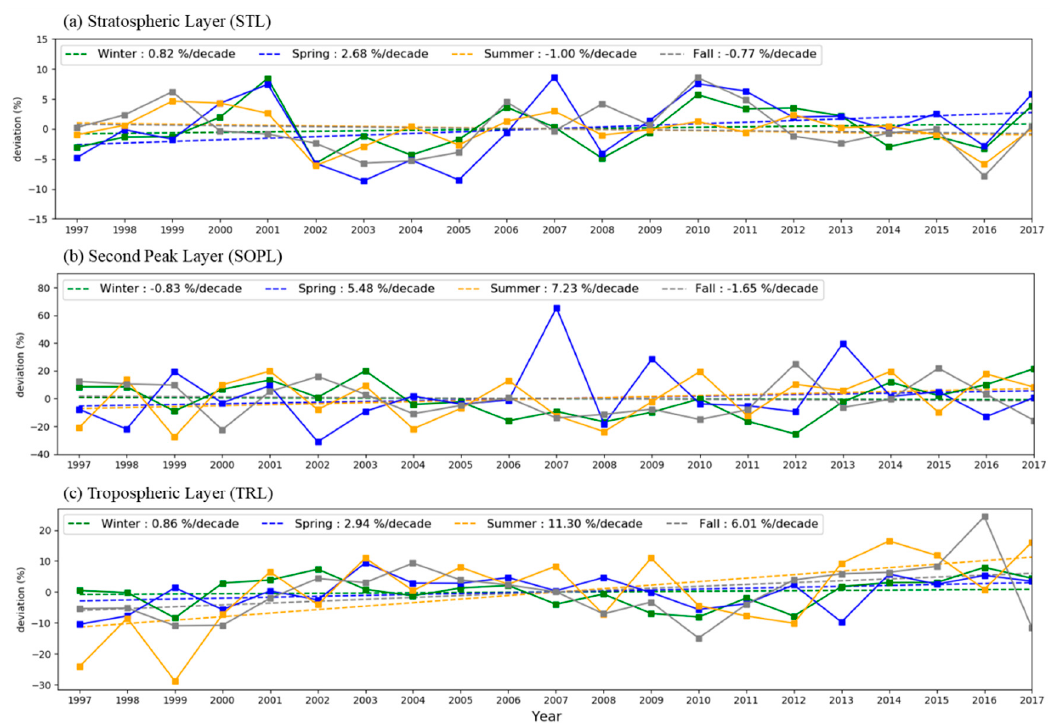
Figure 3. Time series of percent deviations in de-seasonalized average ozone (DU) of three layers—( a ) Stratospheric layer, ( b ) Second ozone peak layer, ( c ) Tropospheric layer—for each season. The solid and dashed lines indicate annual mean and trend, respectively (green: winter, blue: spring, yellow: summer, gray: fall).